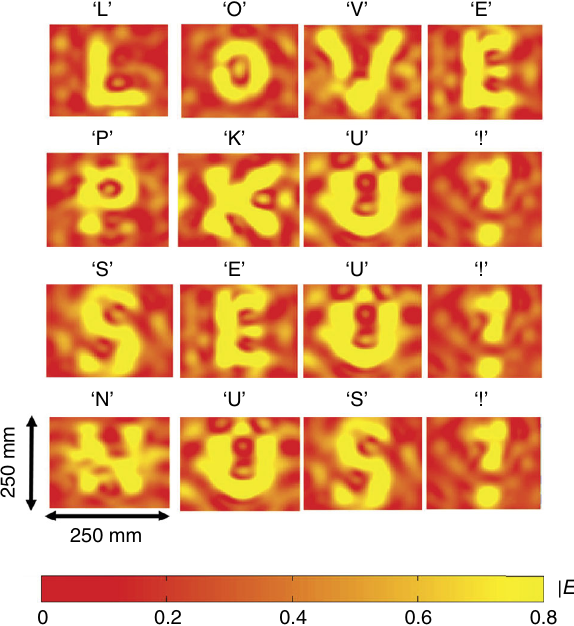
Fig. 5 The experimental results of holograph images with the phase pro fi les in Fig. 3. The experimentally observed holographic images ( E x - fi eld intensity) of ‘ LOVE PKU! SEU! NUS! ’ corresponding to the holograms shown in Fig. 3 are measured at the image plane of Z r = 0.4 m, that agree well with the simulation results illustrated in Fig.